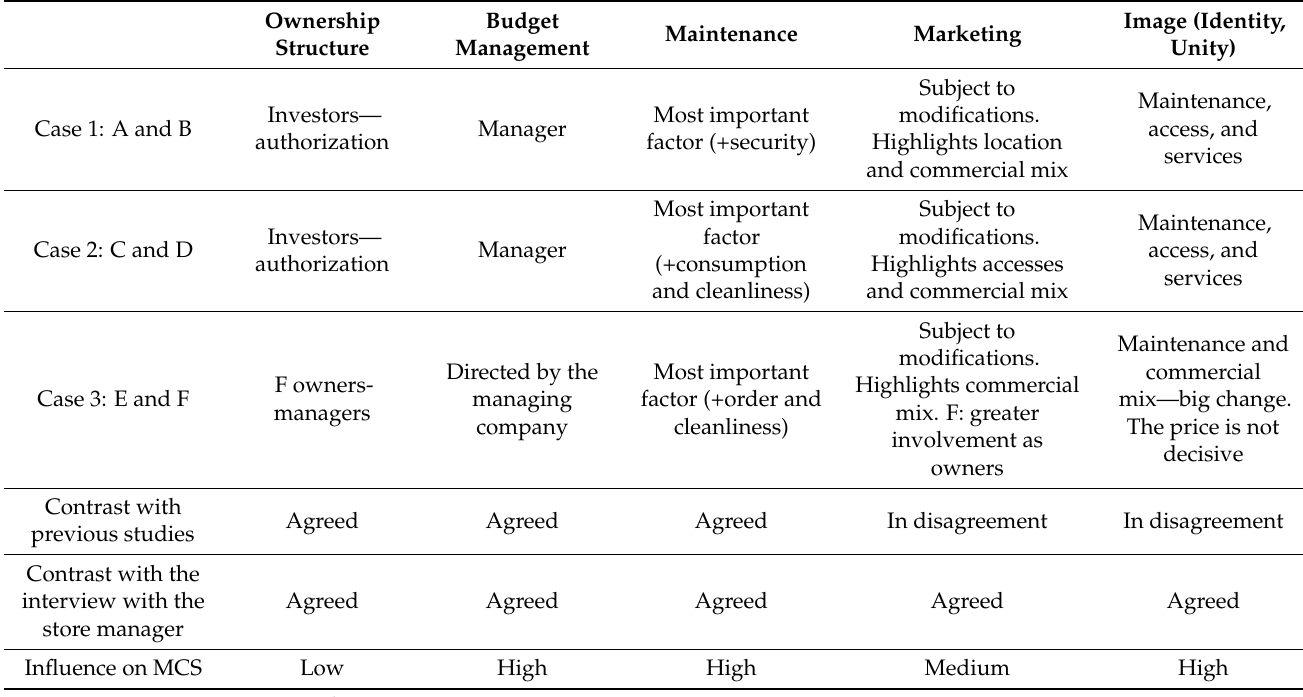
Table 8. Analysis of result 1